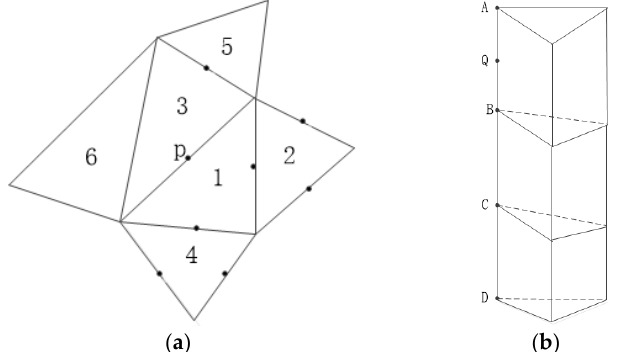
Figure 7. Adjustment of the property values. ( a ) Adjustment along the horizontal layer; ( b ) adjustment along the vertical layer.